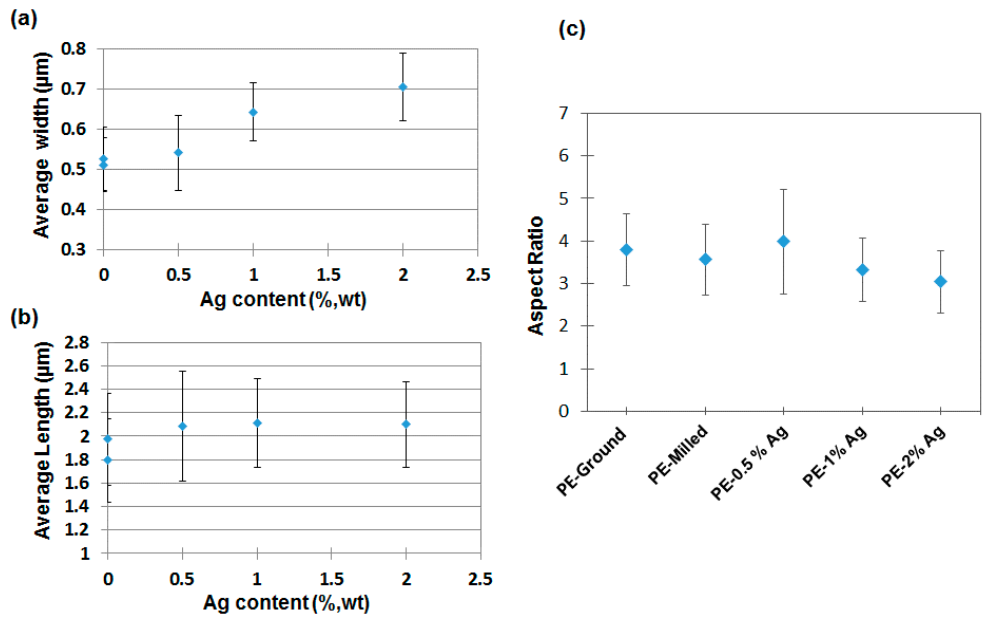
Figure 9. Morphological parameters of the bacteria: ( a ) Average width ( μ m); ( b ) average length ( μ m) and ( c ) aspect ratio (length/width) as a function of the content of silver particles.